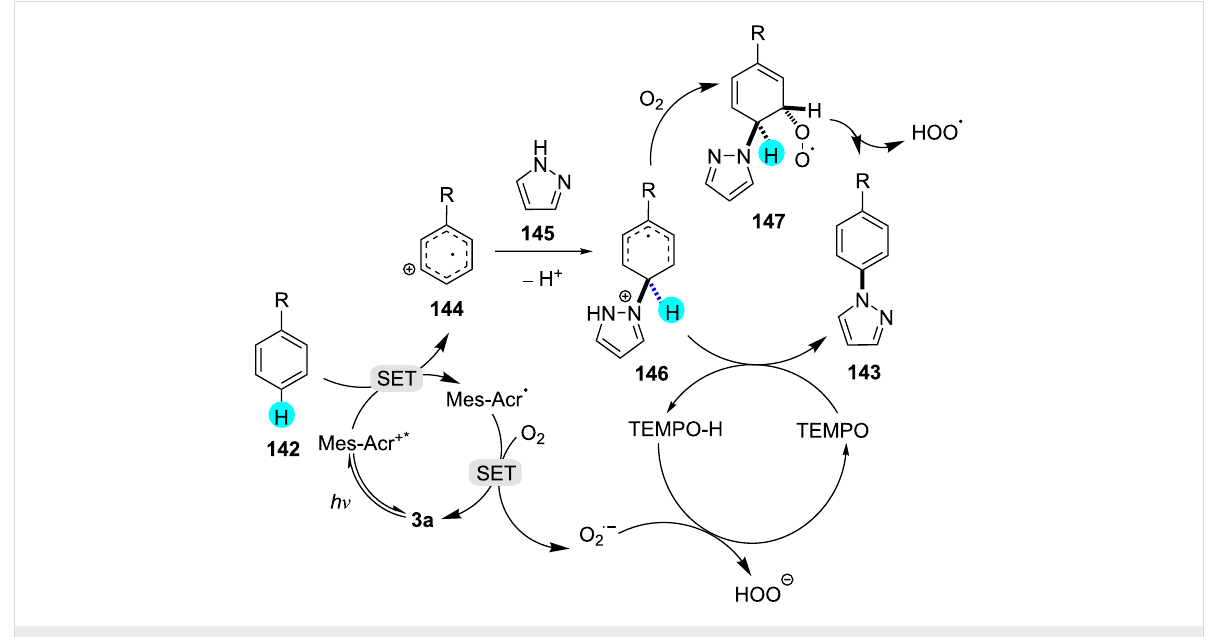
Figure 24: Plausible mechanism for the aerobic amination using acridinium catalyst 3a .